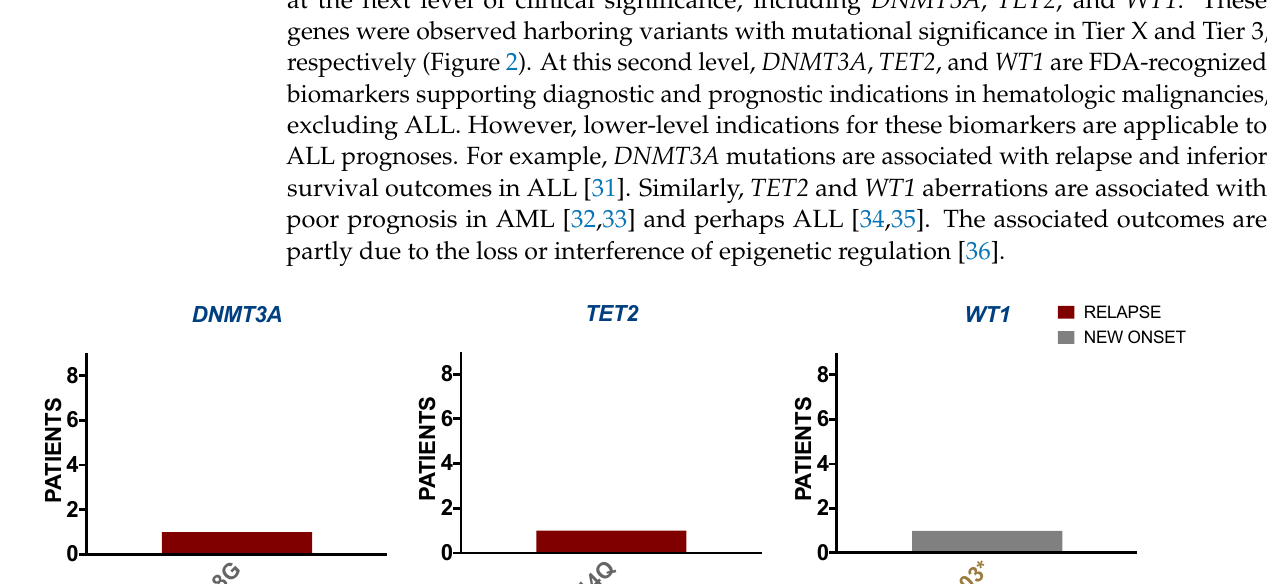
Figure 1. ALL borderland patients harbor tier mutations detected in first level cancer biomarkers with therapeutic po- tential. Variants are shown occurring in new-onset (grey) and relapse (maroon) ALL patients where mutational signif- icance is indicated by Tier 1 (red), Tier 3 (gold), and Tier X (grey) within Level 1 clinically relevant genes (green) includ- ing ROS1 , ATM , and KRAS .